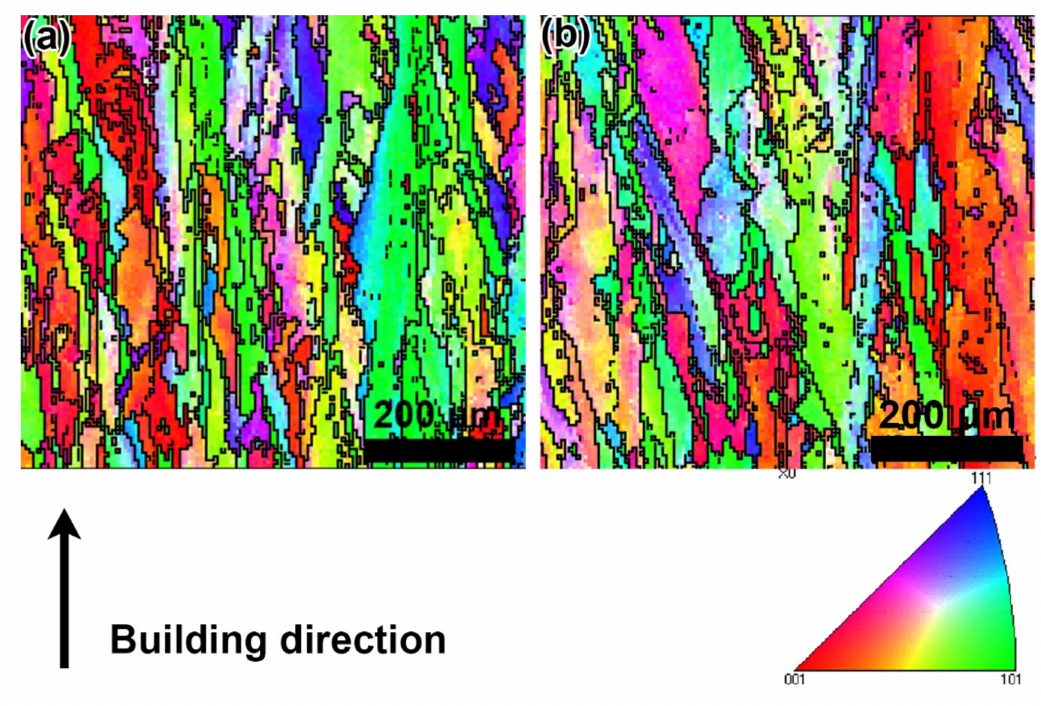
Figure 2. The IPF images of the GTD222. ( a ) as-built sample, ( b ) HTed sample. The SEM images showing the microstructure of the etched as-built and HTed GTD222 samples were shown in Figure 3. The microstructure of the as-built GTD222 was a typical cell and columnar structure, which was similar to the AM processed superalloys. No γ ’ or carbide was precipitated in the cell structures due to the high cooling rate, as shown in Figure 3a. In the HTed GTD222, the cell structures were disappeared and many carbides were precipitated in the γ , as highlighted in Figure 3b. The γ ’ was also observed in the sample, as indicated in Figure 3b.